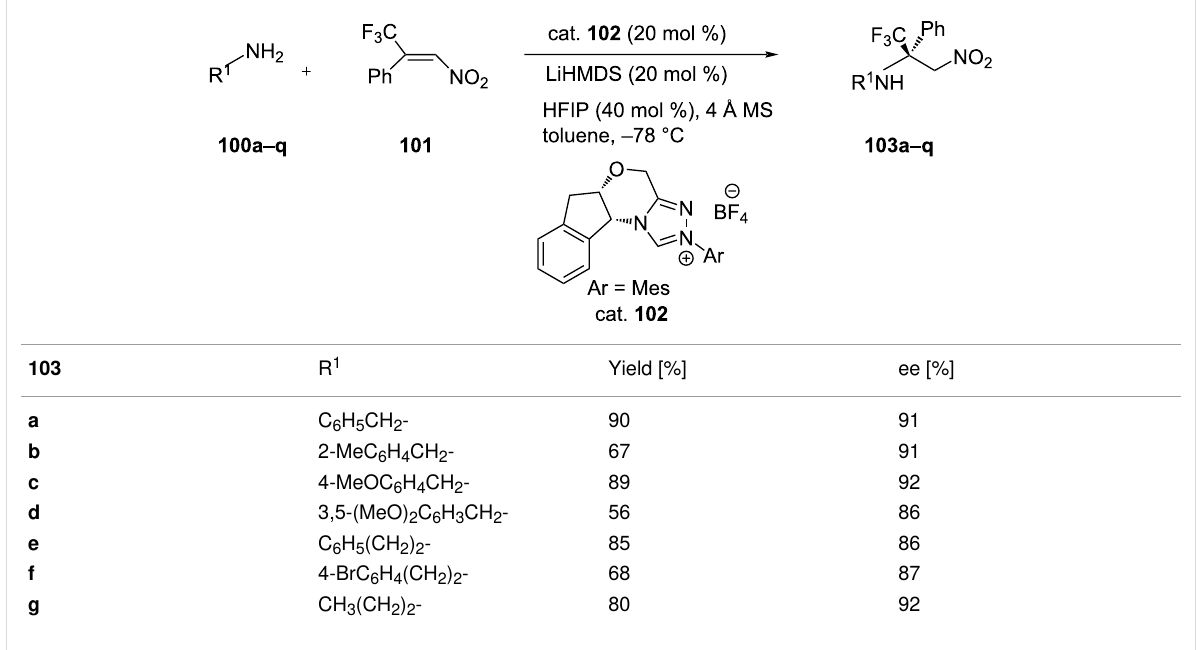
Table 23: Aza-Michael addition of primary amines to β -trifluromethyl- β -phenylnitroolefin catalyzed nitrogen heterocyclic